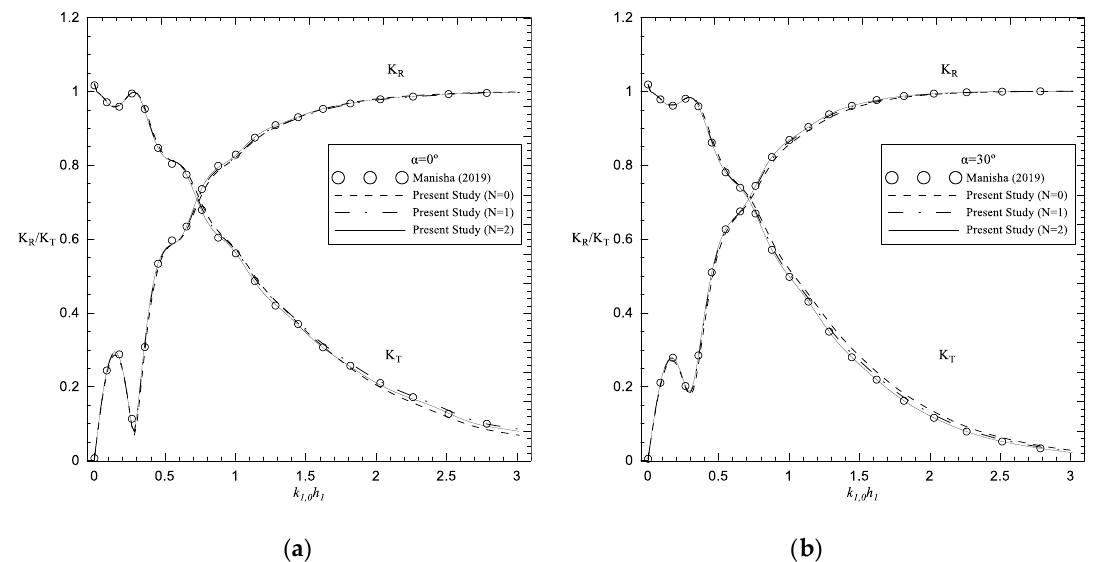
Figure 7. Comparison of the reflection coefficients from the present study with the results from the literature for the (a) normal and (b) oblique water-wave-scattering by a rectangular structure behind a parabolic breakwater.